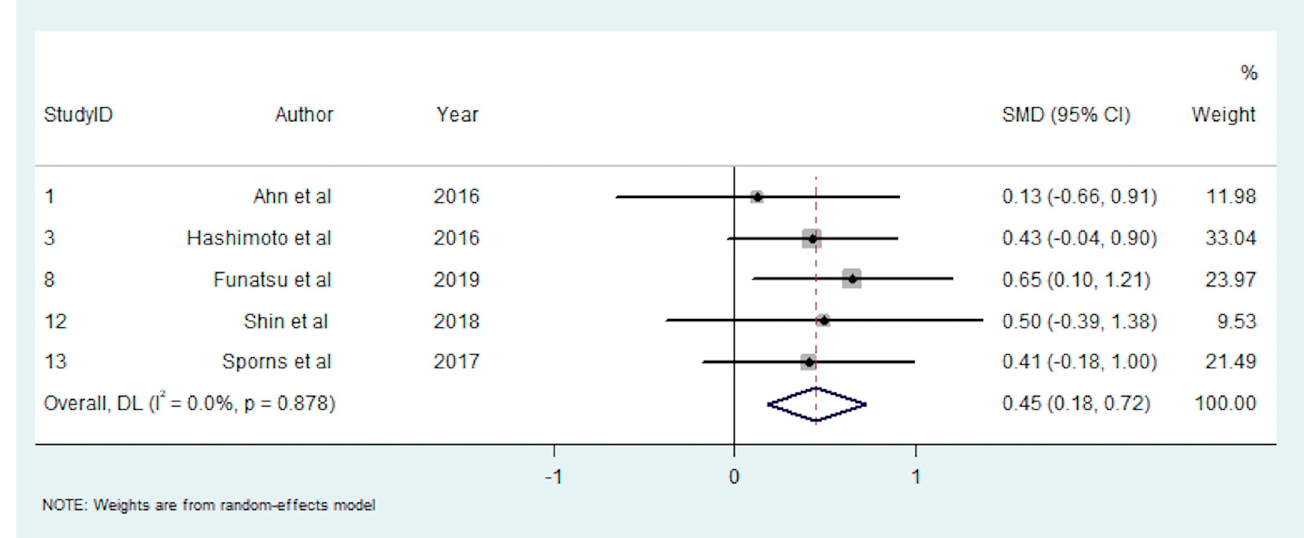
Figure 6. Forest Plot of Meta-analysis on RBC Content and Successful Recanalisation. Abbreviations: DL: DerSimonian and Laird method, SMD: Standarized Mean Difference, CI: Confidence Interval, RBC: Red Blood Cell.